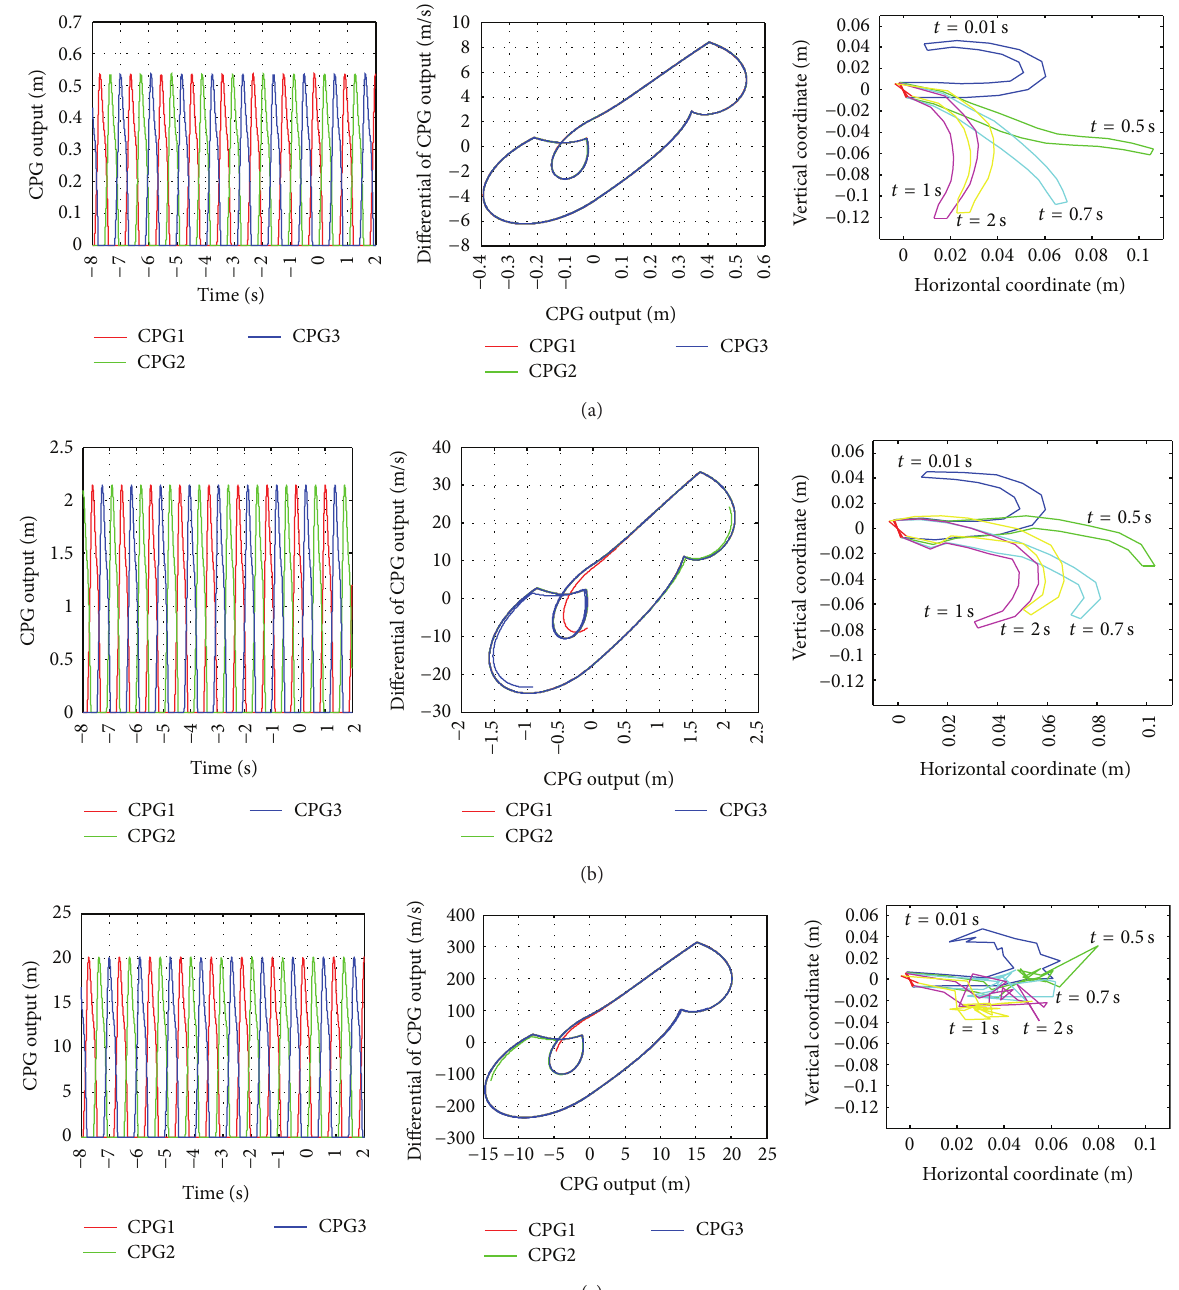
Figure 5: Outputs and phase diagrams of three coupled CPGs and a sequence of octopus arm movements with the parameter 𝑒 (from left to right): (a) 𝑒 = 2 , (b) 𝑒 = 8 , and (c) 𝑒 = 75